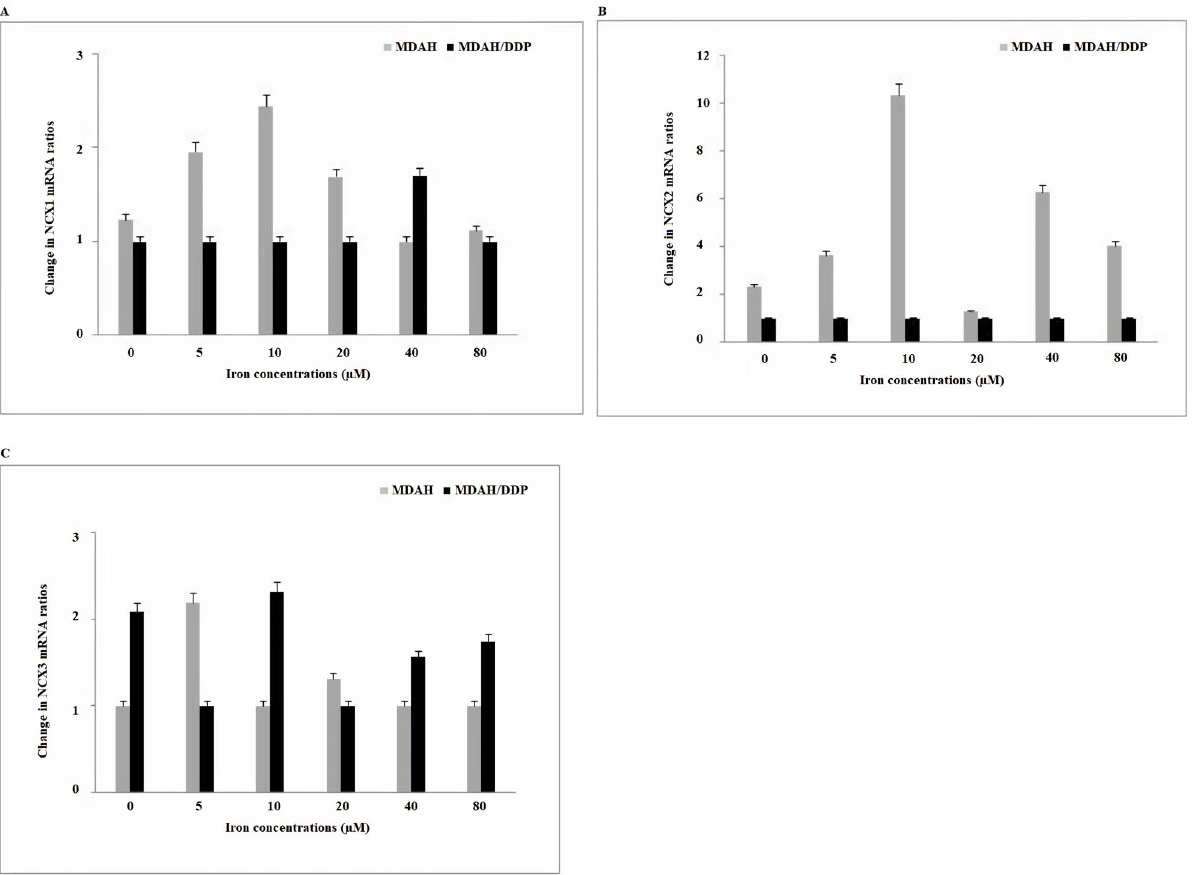
Figure 4. Gene expressions of NCX1/2 and NCX3 Ca 2+ exchange carriers found in plasma and nuclear membrane at increasing iron concentrations in MDAH and MDAH/DDP cells. The levels of change in mRNA expression rates for each sample were determined with respect to β-actin by RT-PCR method. A: NCX1 ; B: NCX2 ; C: